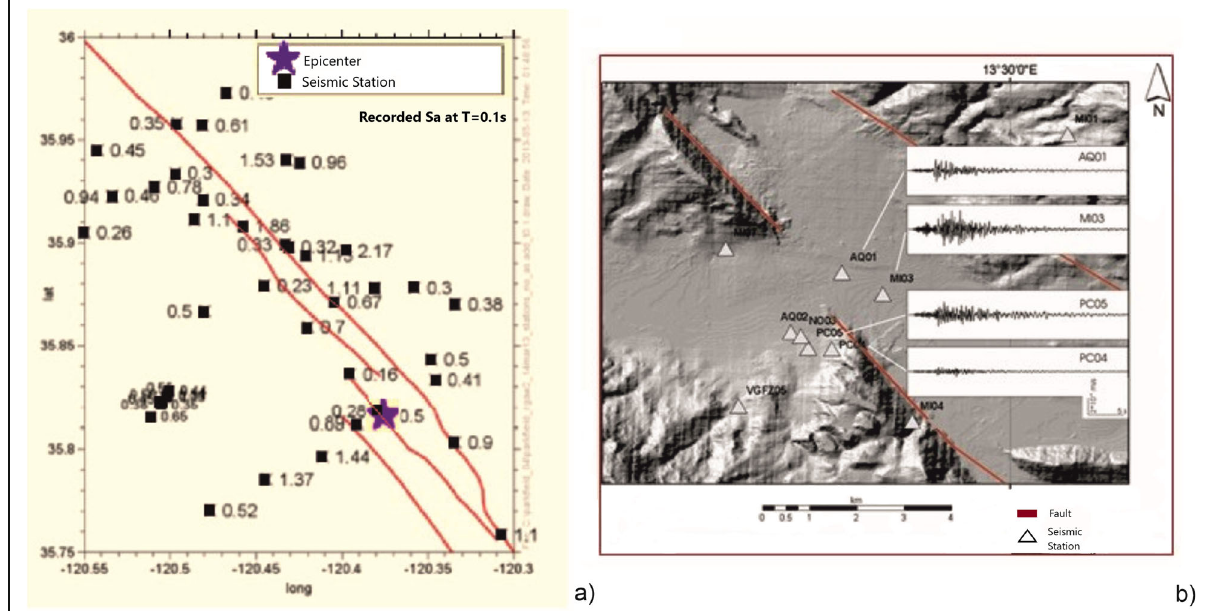
Fig. 4 a Measures of PSA during the Parkfield earthquake 2004 (6 M w ) are reported near the active fault at the measure seismic stations (After Boore 2014b, modified); b Onna sector of Aterno River Valley: the records are for an aftershock of 3.2 Ml